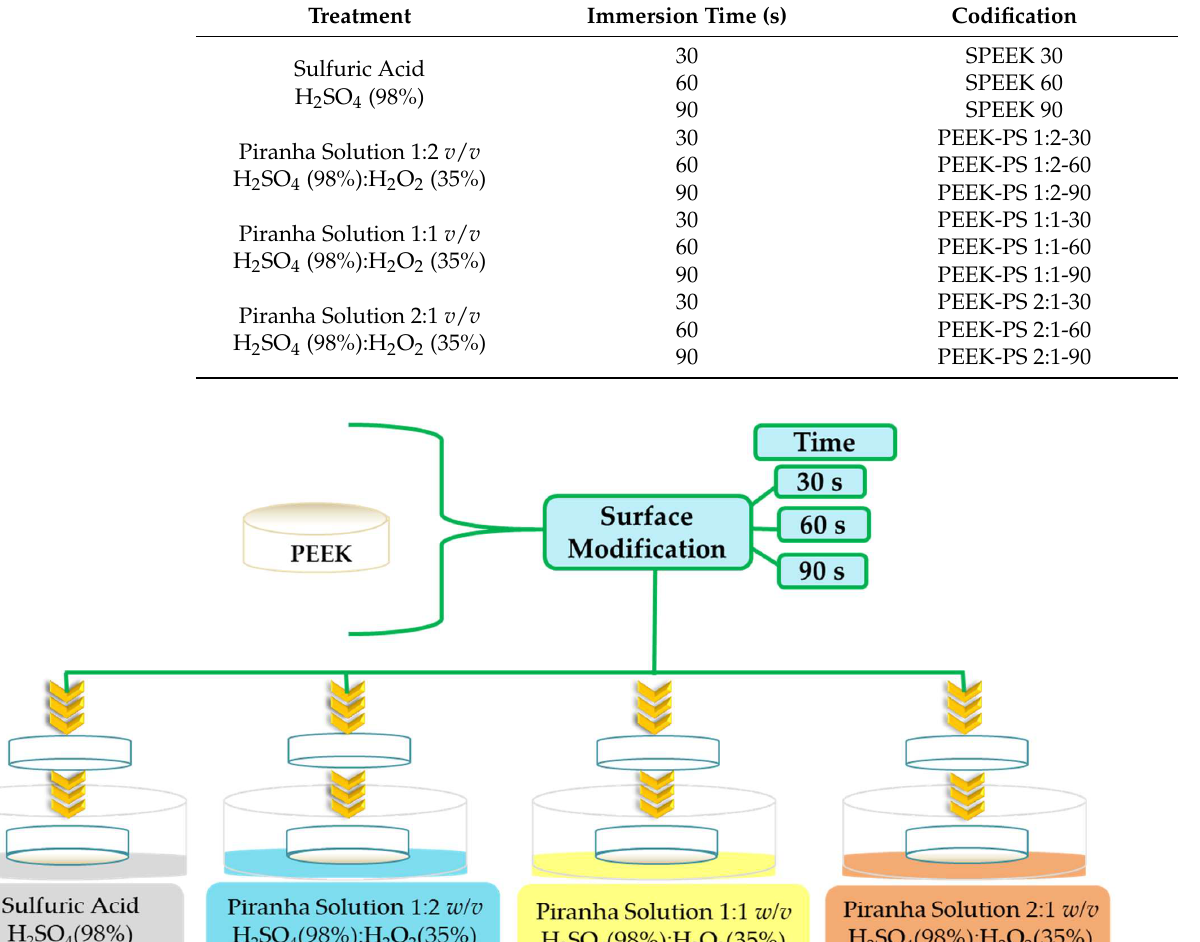
Table 1. Test parameters and sample identification.